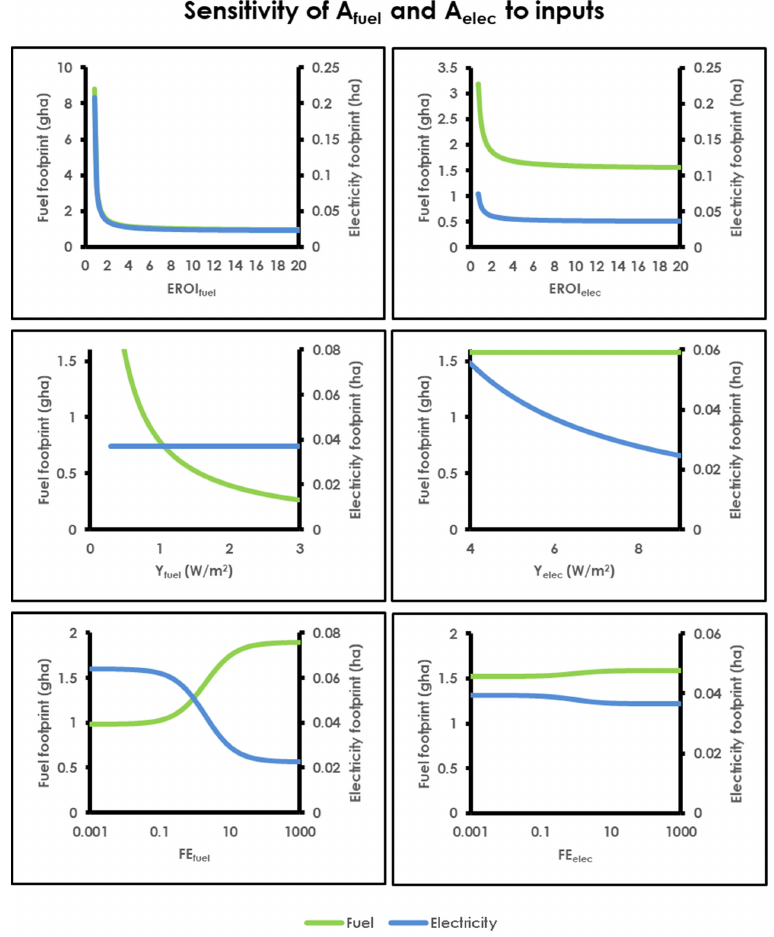
Figure 2. Sensitivity analysis results, reported as per capita fuel and electricity footprints for average Australian energy consumption.